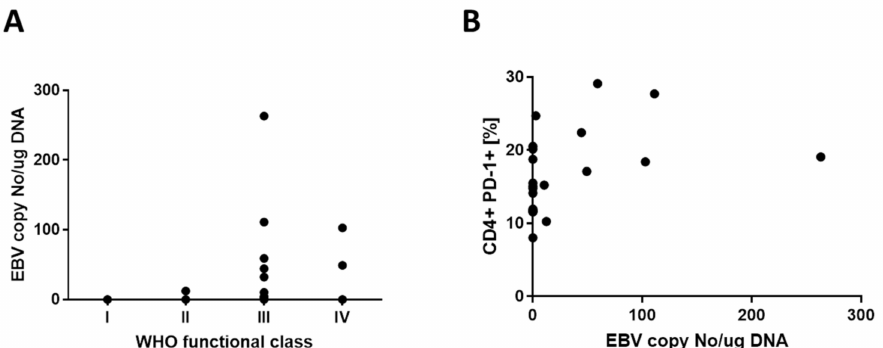
Figure 4. Positive correlation between WHO functional class and the EBV copy number and EBV load and the proportion of PD-1-expressing T helper lymphocytes. Weak, yet statistically significant correlations have been observed for ( A ) WHO functional class and the EBV copy number (r = 0.54, p = 0.005) as well as for ( B ) and EBV load and the proportion of PD-1-expressing CD4 + T cells (r = 0.56, p = 0.0035). Correlation was assessed with the Spearman rank test, and no regression line is plotted on the